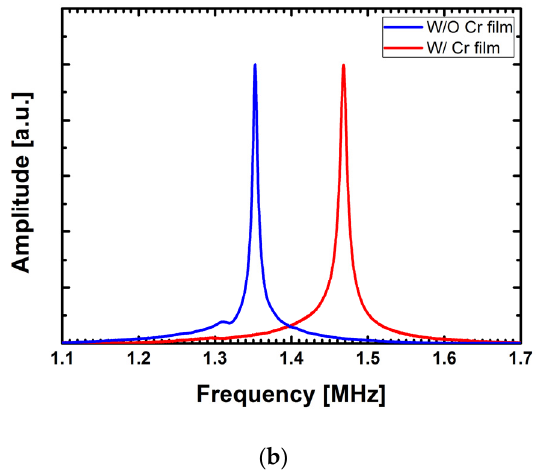
Figure 6. ( a ) Time-domain waveforms of the micromechanical resonators in the first flexural vibration mode; ( b ) frequency responses obtained from the fast Fourier transform (FFT) of the time-domain waveforms.